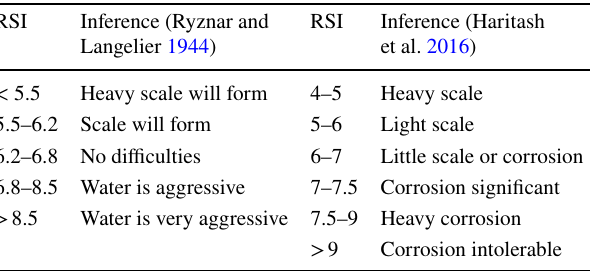
Table 7 Classification of water for industrial purposes based on